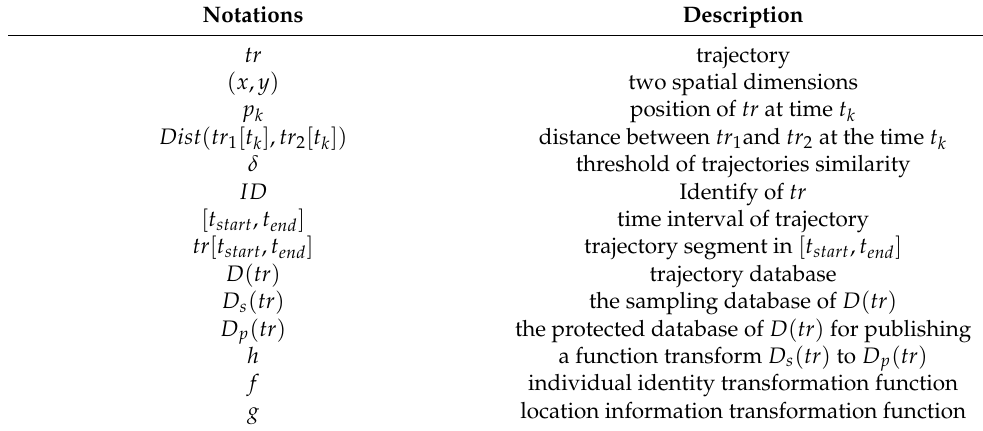
Table 2. Important notations in this